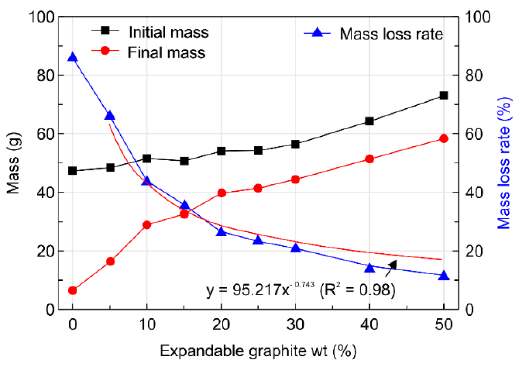
Figure 7. Mass loss rate variations with expandable graphite content.